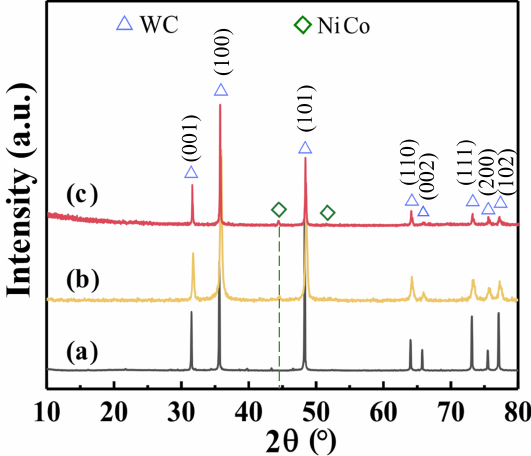
Figure 3. The XRD of sintered cemented carbide: (a) raw WC; (b) WC-Ni/Co EP ; (c) WC-Ni/Co CP. The actual density of the sample was tested by the Archimedes drainage method, and the relative density of the different carbide was obtained. As can be seen from Table 3, the relative density of the cemented carbide prepared by co-precipitation was relatively large, close to 100%. The relative density of the sintered WC-Ni EP was the lowest, at